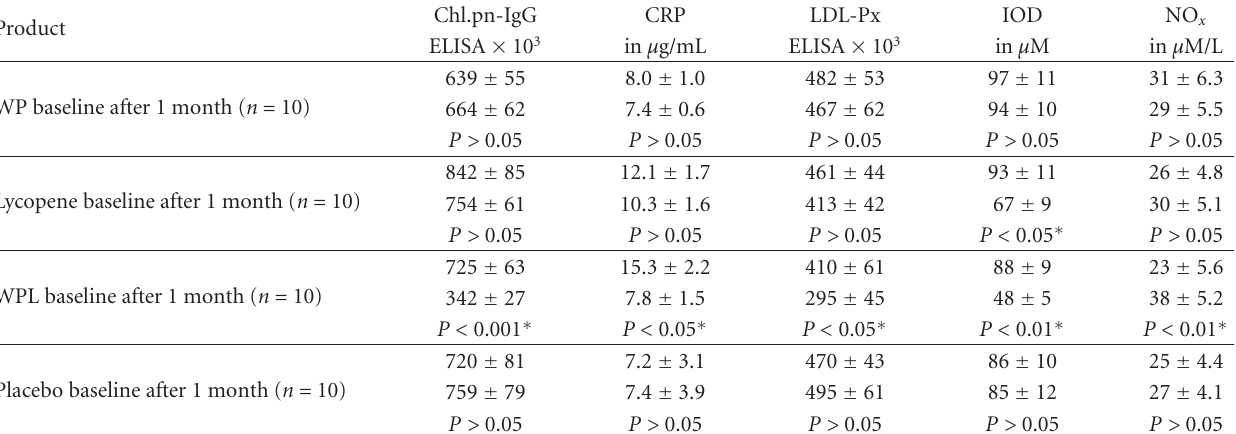
Table 3: E ff ect of markers of oxidative stress, inflammation, and NO.